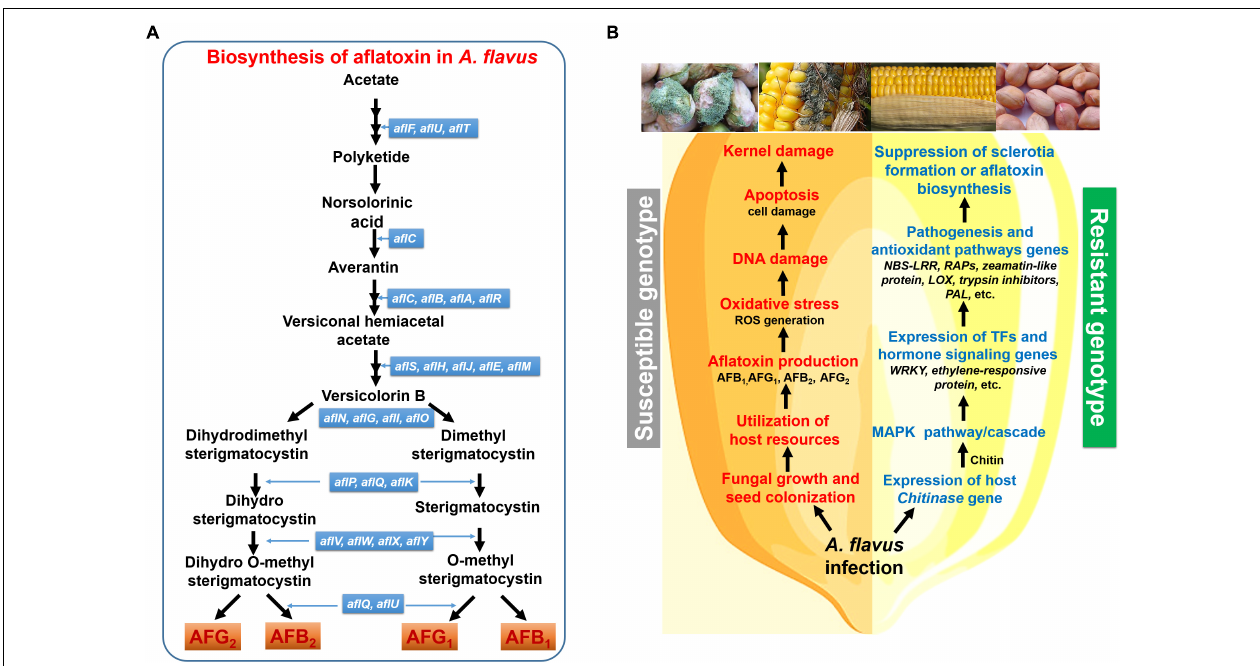
FIGURE 2 | A simplified representation of the aflatoxin biosynthesis pathway and the defense response mechanism in groundnut or maize. (A) Aflatoxin biosynthesis in A. flavus ; (B) the aflatoxin biosynthesis pathway involve multiple genes which co-express together for the formation of toxin secondary metabolites. In the susceptible genotype infection leads to the A. flavus seed colonization and production of aflatoxin which causes suppression of host defense mechanism results in ROS generation and DNA damage causing cell death (apoptosis). In contrast, in resistant genotypes infection causes induction of host defense mechanism that include MAPK pathway which induces WRKY TF expression which is a key regulator of pathogenesis and antioxidant related genes involved in the suppression of aflatoxin biosynthesis pathway or detoxification of